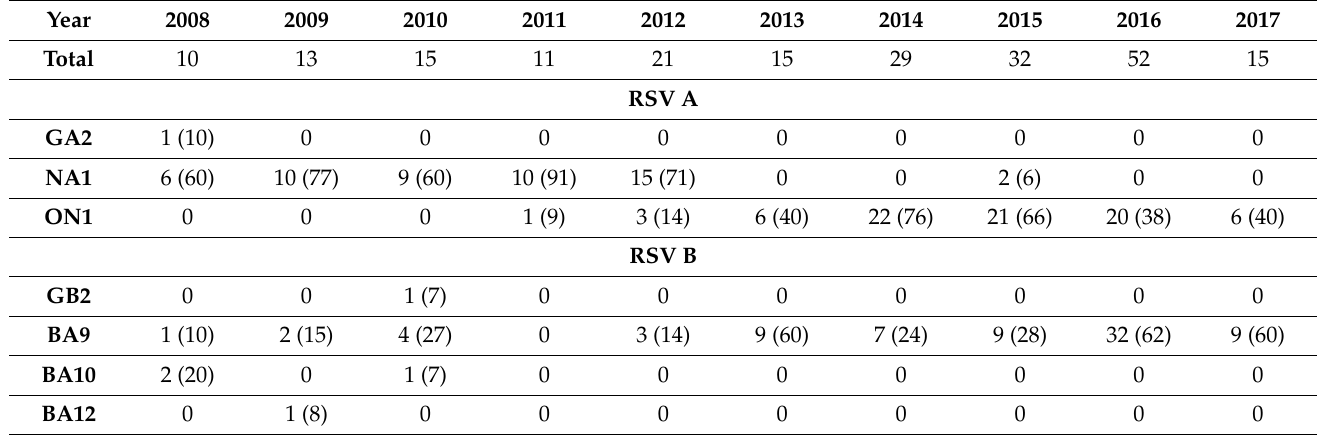
Table 1. Annual distribution of 213 RSV isolates in Taiwan,